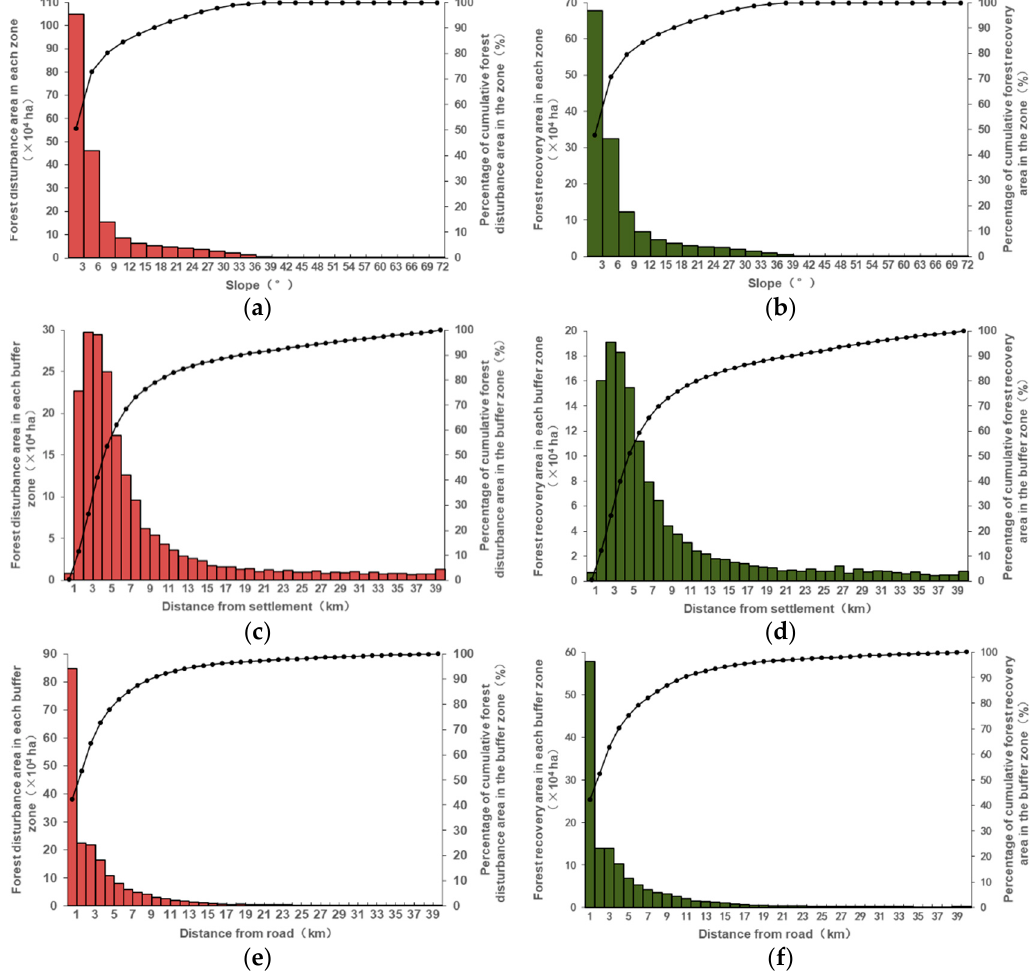
Figure 6. Natural–human background characteristics of forest change. ( a ) Slope and forest disturbance area; ( b ) slope and forest recovery area; ( c ) distance between settlements and forest disturbance area; ( d ) distance between settlements and forest recovery area; ( e ) distance between roads and forest disturbance area; ( f ) distance between roads and forest recovery area. The left vertical ordinate indicates the forest disturbance or recovery area in each slope, settlement, and road buffer zone. The right vertical ordinate indicates the cumulative percentage of the forest disturbance or recovery area in each slope, settlement, and road buffer zone.